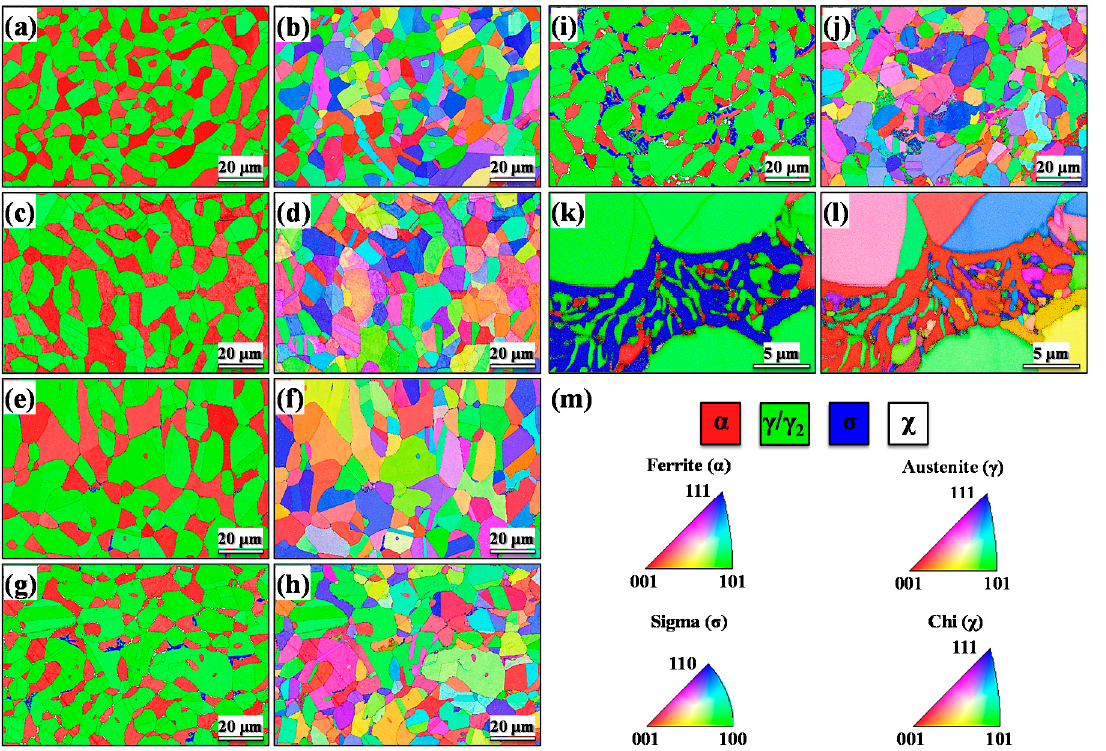
Figure 3. Electron backscatter diffractometry (EBSD) phase map of the specimens in the following conditions: ( a ) solubilized and aged for ( c ) 15 min, ( e ) 30 min, ( g ) 60 min, and ( i , k ) 180 min. Inverse pole figure (IPF) orientation maps of the specimens in the following conditions: ( b ) solubilized and aged for ( d ) 15 min, ( f ) 30 min, ( h ) 60 min, ( j , l ) and 180 min; ( m ) color code map for IPF [001]. Note that the aged specimen for 180 min has two images (medium and high magnification).